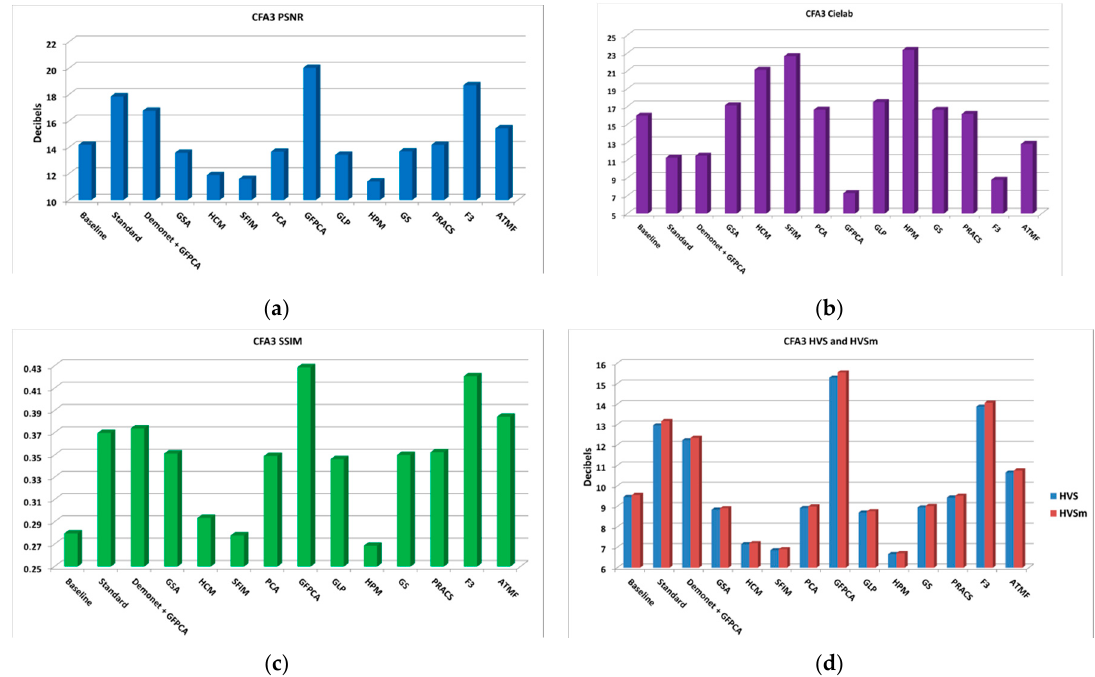
Figure 8. Averaged performance metrics for all the low lighting images at 10 dBs SNR (Poisson noise). ( a ) PNSR; ( b ) CIELAB; ( c ) SSIM; ( d ) HVS and HVSm.